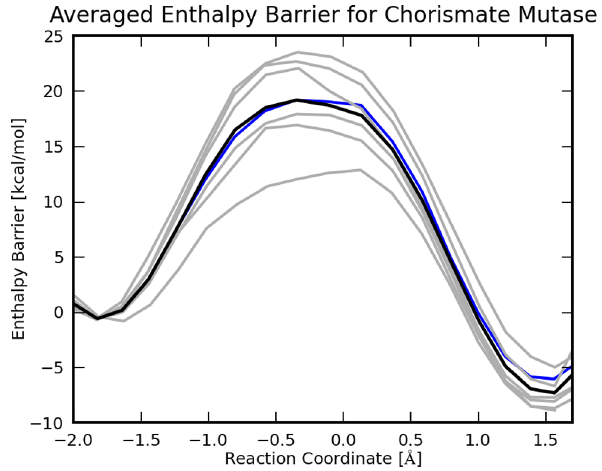
Figure 7. Reaction Enthalpy Profile for chorismate mutase. The 7 profiles are calculated with ONIOM at the MP2/cc-pVTZ:EFMO-RHF/6- 31G(d) level of theory. The black line is the average reaction energy, gray lines are individual reaction paths. The blue line is the reaction path discussed in detail, in the results section.